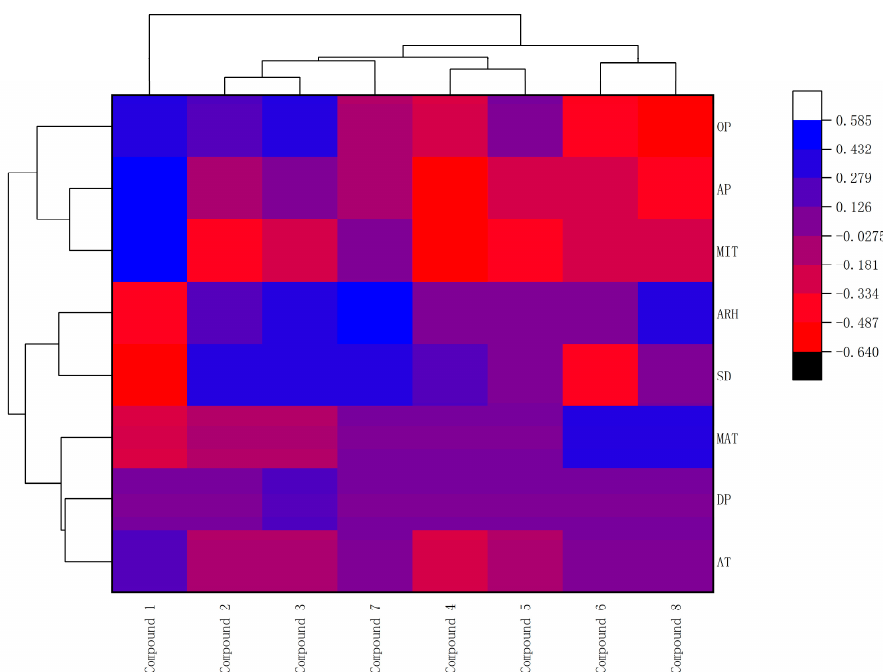
Figure 10. Dendrogram and heatmap of hierarchical cluster analysis of climate factors among eight flavonoids of W. japonica. Concentrations are illustrated by a color gradient from blue (high) to red (low). Compound 1–8: isotrifolin, rutin, myricetin deoxyhexoside, quercetin-3-rutinoside, luteolin 6-C-glucoside, quercitrin, genestein G2, luteolin-4 ′ - O -(6 ″ -trans-caffeoyl)- β - D -glucopyranoside.